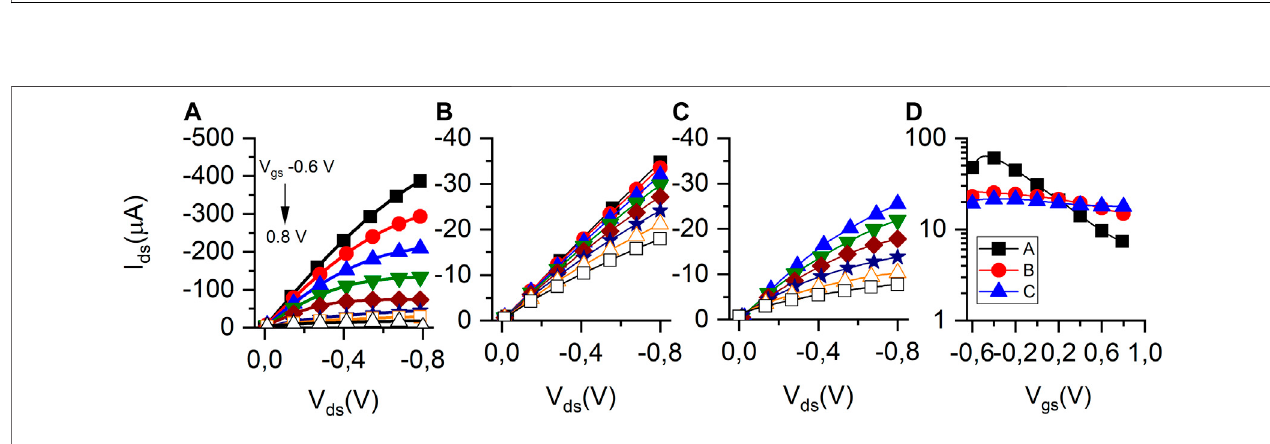
FIGURE 6 | Output curves of transistors obtained from mixtures A (A) , B (B) and C (C) prepared by 1,500 s electrospinning and an applied gate voltage: 0.6 ( ■ ), -0.4 ( C ), -0.2 ( ▲ ), 0 ( ▼ ), 0.2 ( ◆ ), 0.4 ( q ), 0.6 ( ☐ ), and 0.8 ( △ ) V, at a sweep rate of 60 s. (D) Transfer curves of transistors of Mixtures A ( ■ ), B ( C ) C ( ▲ ) prepared by 1,500 s electrospinning at a V DS of -0.6 V. For visual acuity: the solid lines connect every measured data point and the symbols are drawn at every fi fth data point.